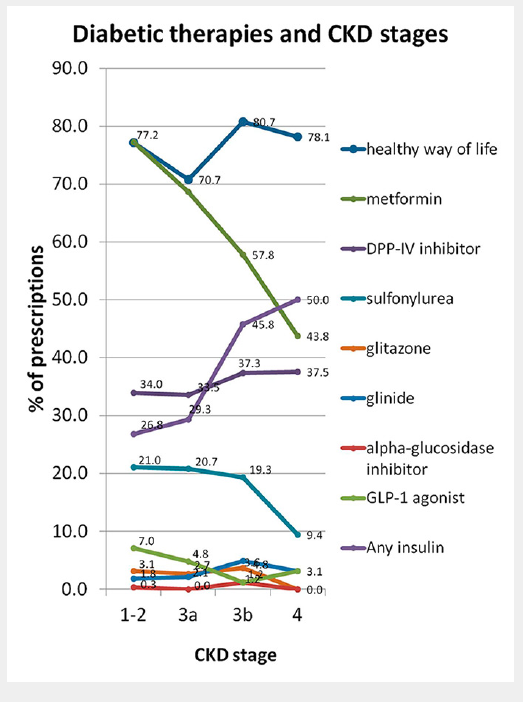
Figure 3 Antidiabetic class prescriptions (%) and chronic kidney disease (CKD) stage.